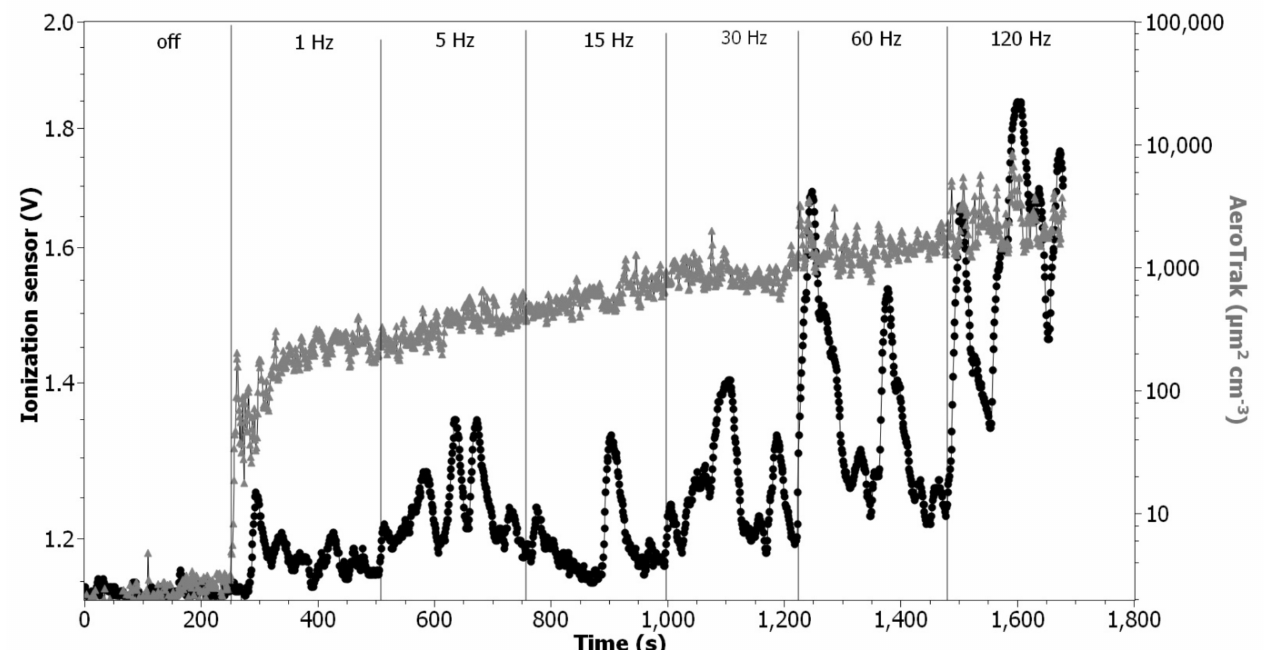
Figure 10. Comparison of ionization sensor and TSI AeroTrak 9000 responses to diesel soot concentration changes. The average air parameters during experiment: temperature 25.2 ± 0.3 ◦ C, relative humidity: 49.3 ± 0.8%, pressure: 100.73 ± 0.02